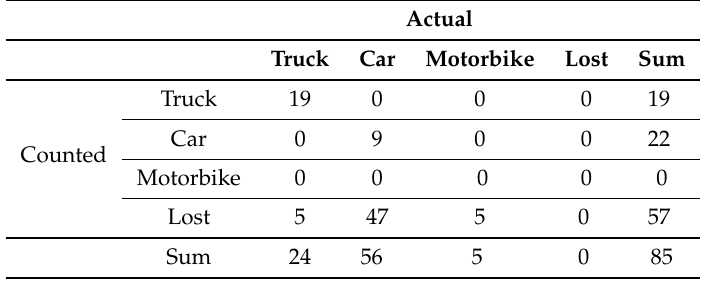
Table 6. Counting results per vehicle type from the confederation bridge with 500 ms request interval.